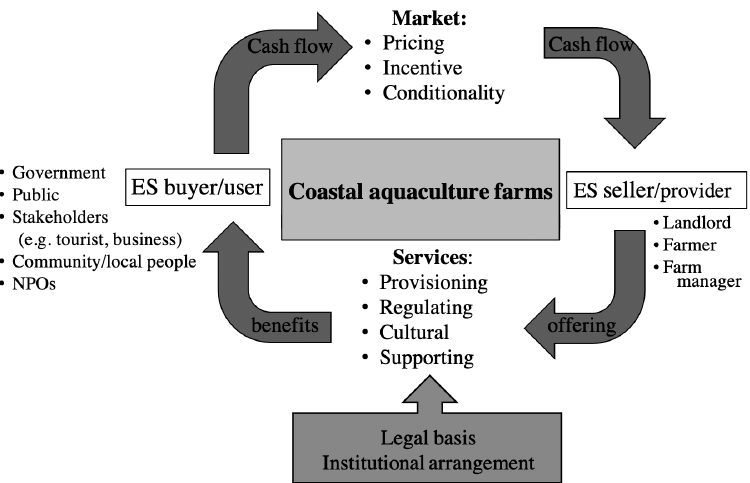
Fig. 3. Framework of the payment for ecosystem services scheme designed for Taiwan’s aquaculture industry. ES: ecosystem service; NPOs: non-profit